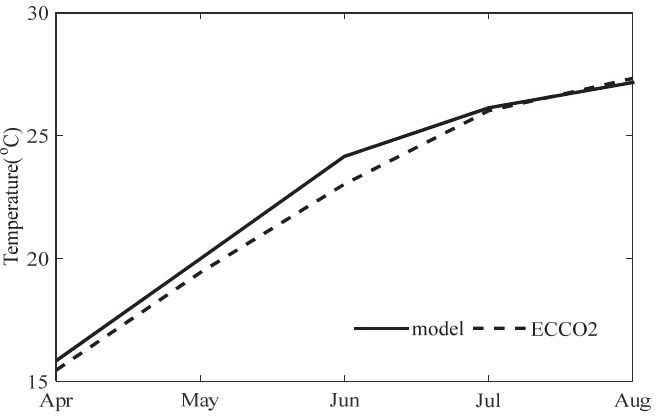
Figure 4. The seasonal cycle of ECCO2 SST and model result from April to August averaged over 29° N–32° N, 122.5° E–124° E from 1998 to 2010.